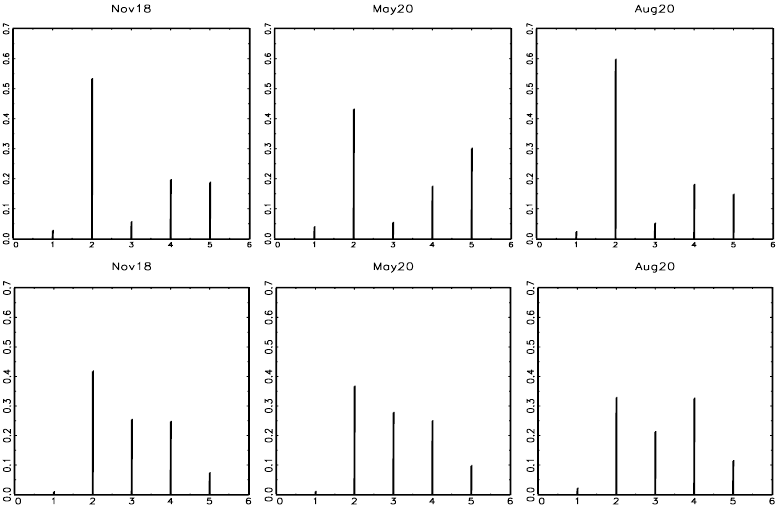
Figure 2. Frequency distributions of inflation expectations ( first row ) and perceptions ( second row ) for selected